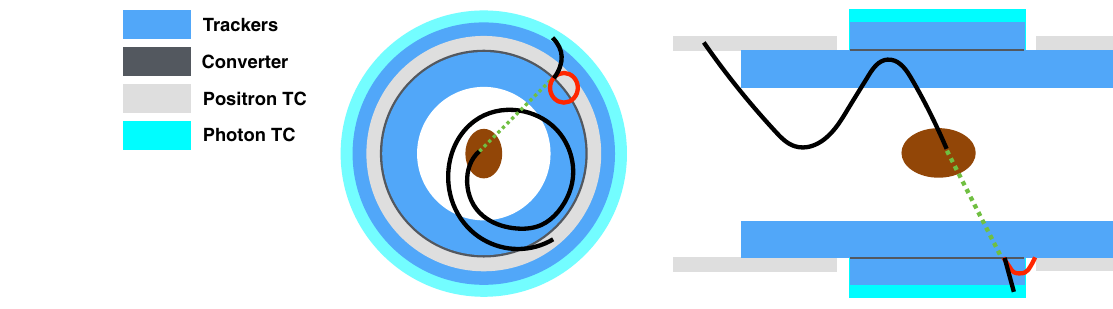
counters (TC). A typical μ + → e + γ event with converted photon is shown (positrons in black, photon in green, electron in